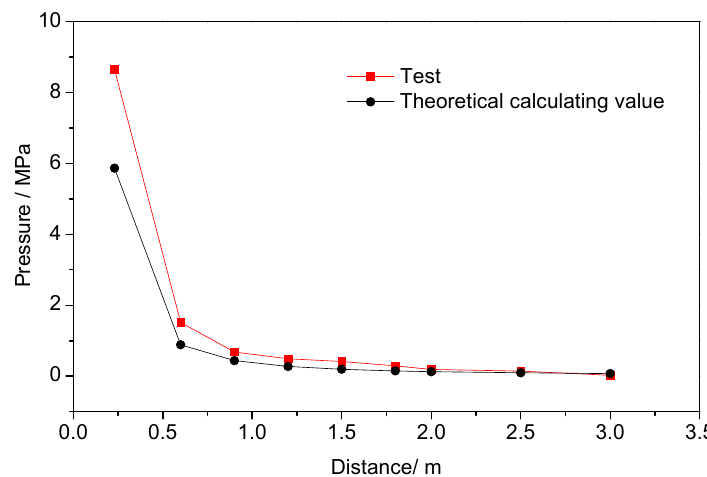
Figure 9. Peak pressure test value fit curve and theoretically calculated value curve at different distances.